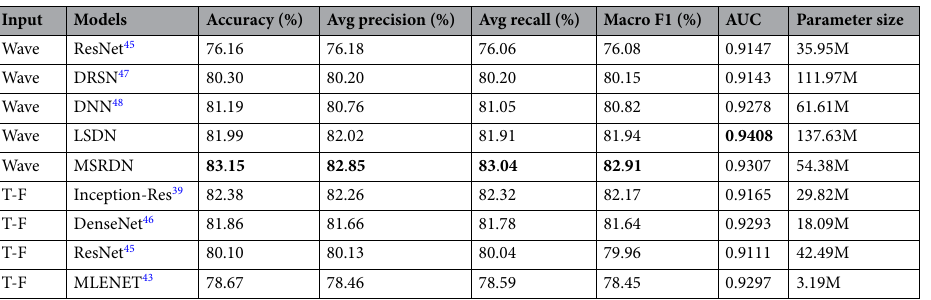
Table 3. Classification experimental